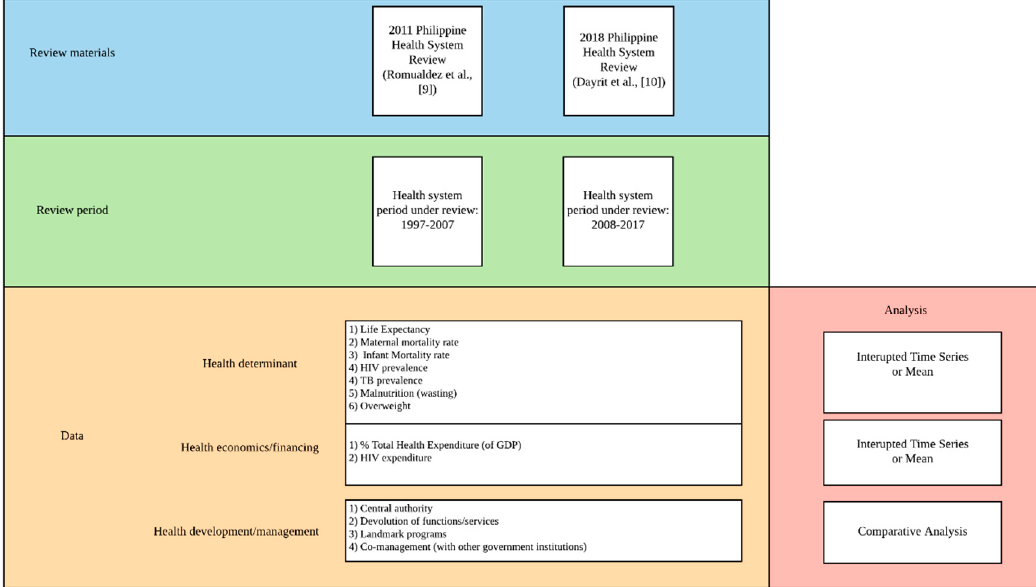
Figure 1. Health system analysis methodological framework.